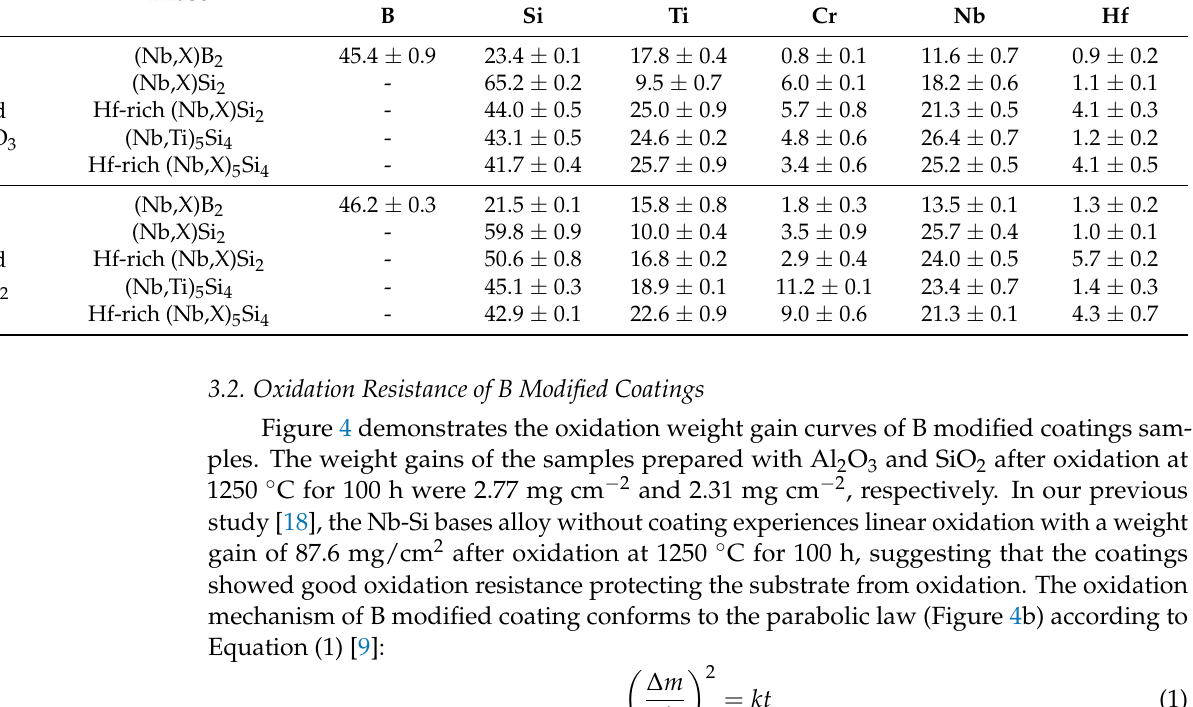
Figure 3. BSE image of cross-section morphologies of B modified silicides coatings prepared with Al 2 O 3 ( a ) and SiO 2 ( b ); ( a’ ) and ( b’ ): enlarge BSE images of the outer layer of the coatings. Table 1. Element composition (at.%) of B modified silicides coatings prepared with Al 2 O 3 and SiO 2 filler.